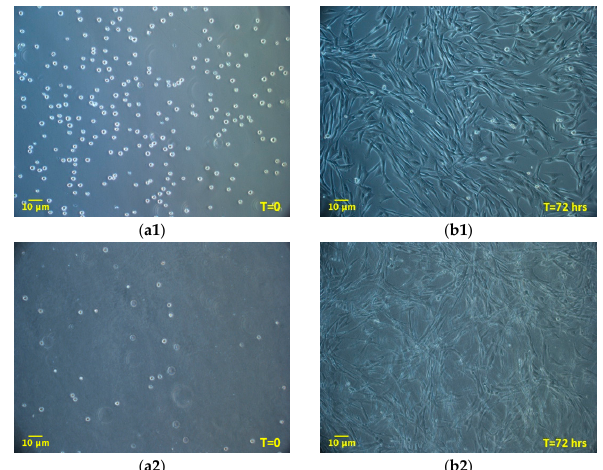
Figure 1. Morphology of adipose tissue derived mesenchymal stem cells (ADMSCs) cultured on plastic surface ( a1 , b1 ; 100×) or embedded in the 3D fibrin-based matrix ( a2 , b2 ; 100×). When seeded on plastic surface ADMSCs take on the classic fibroblast-like shape ( b1 , 72 h). When maintained inside